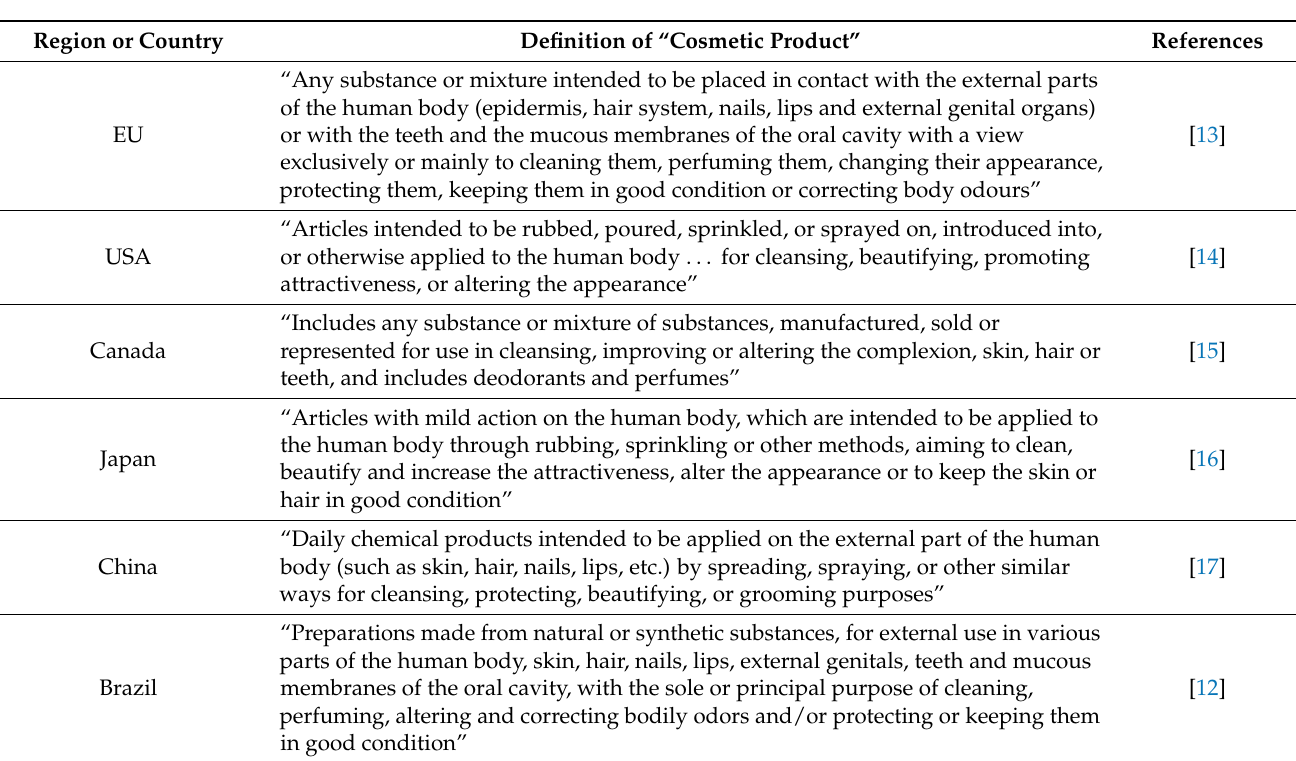
Table 1. Definition of “Cosmetic Product” by country or